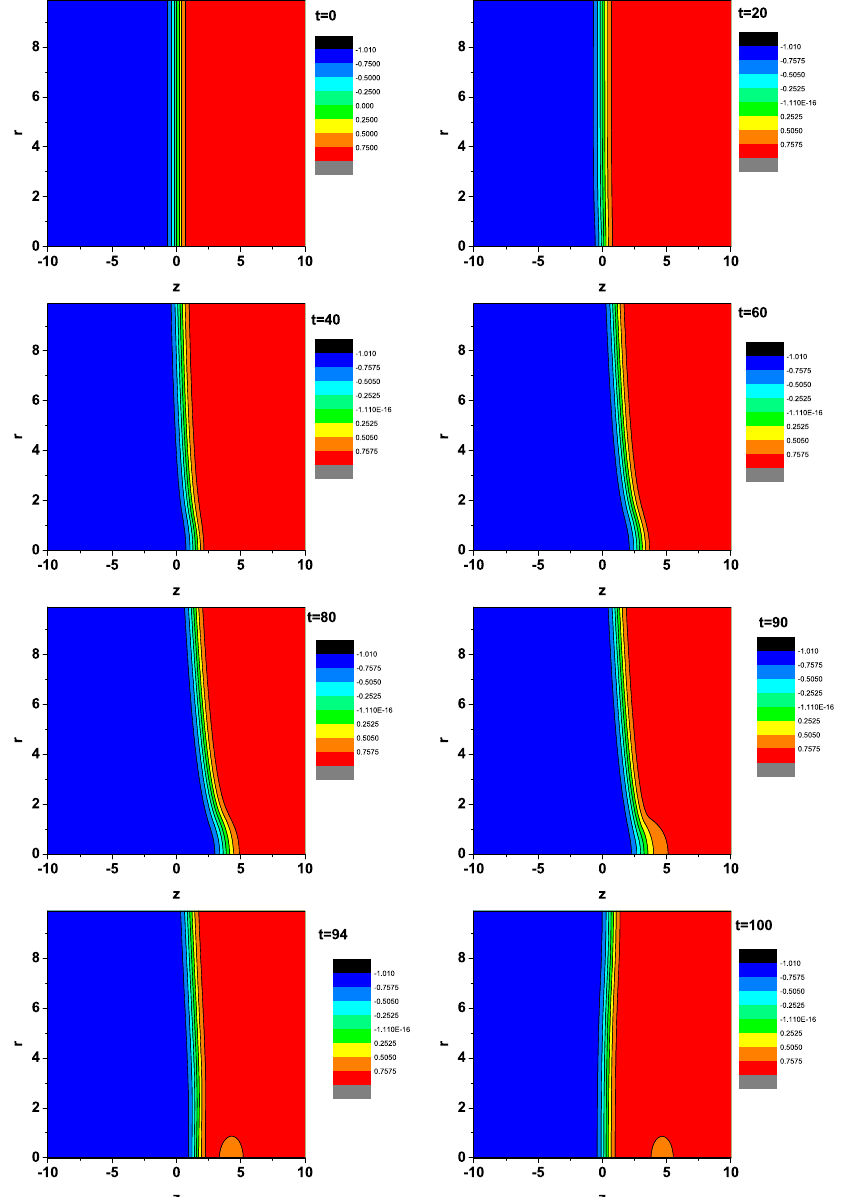
Figure 2 . Distortion of the wall in cylindrical coordinates ( r, z ) , during the collision with a massive object moving in the z -direction. The color code represents the values of the scalar filed. The initial conditions are chosen to be m = 10 4 , R = 1 . 5 , v O = 0 . 1 , A = 0 . 5 and x 0 = − 3 . 5 . At t = 0 , the domain wall is located at z = 0 without any distortion. At t = 20 , the wall is pushed by the object to the right around r = 0 and z = 0 . From t = 40 to t = 80 , the distortion becomes clearer. At t = 90 , the object starts to separate from the wall, where a significant bump can be observed. From t = 94 to t = 100 , the object is completely separated from the wall, and a separate closed region with φ = Λ (new vacuum) is created. This is a bubble of the scalar field formed around the massive object. The wall bounces back to its equilibrium configuration. There are domain wall waves generated in this process, but they cannot be clearly seen in these plots because of the small